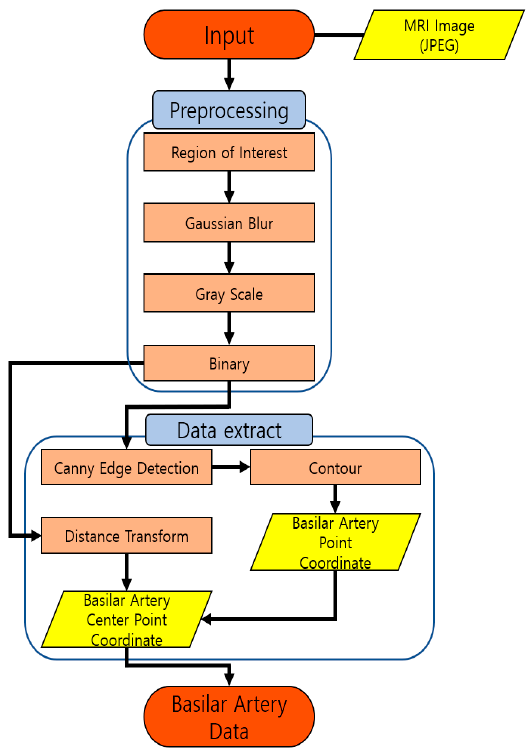
Figure 1. Basilar artery data-extraction flowchart.